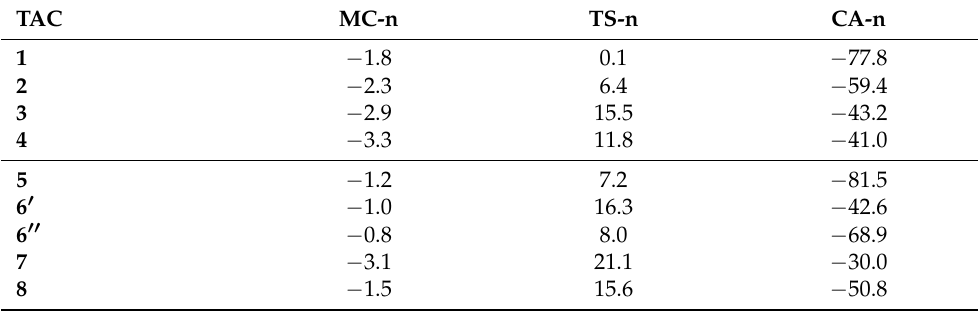
Table 3. MPWB1K/6-311G(d,p) gas phase relative electronic energies, in kcal · mol − 1 , with respect to the separated reagents, of the stationary points involved in the 32CA reactions of TACs 1 – 8